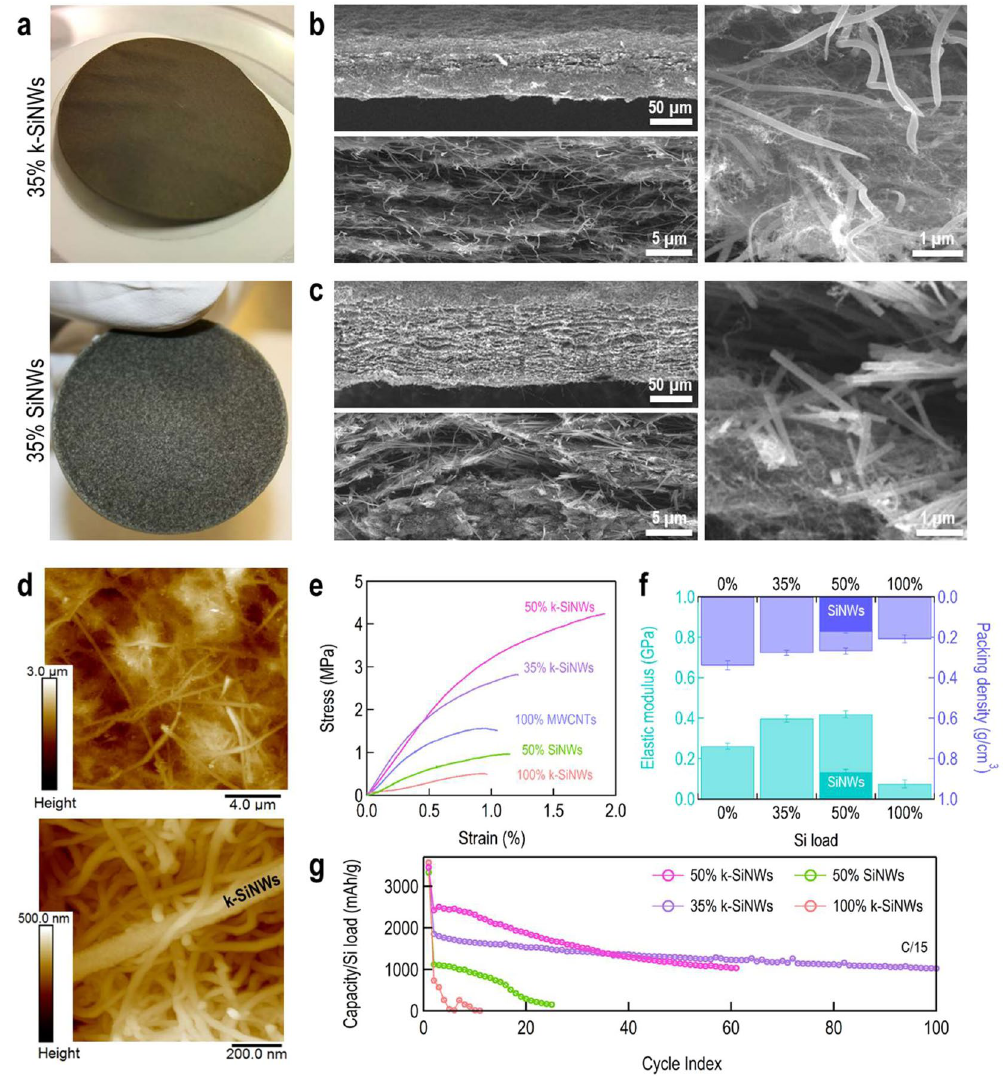
Figure 3. k-SiNWs vs. SiNWs electrode configurations. Optical images of the assemblies with a content of 35% wt. k-SiNWs and 35% wt. SiNWs ( a ). The k-SiNWs assembly presents an uniform color, indicating an homogenous distribution of elements. On the other hand, with the SiNWs-based assembly, distinct regions are identifiable, dominated by either SiNWs or MWCNTs. SEM images with details on the composition of the k-SiNWs assembly ( b ) and SiNWs assembly ( c ). Topography information as revealed by atomic force microscopy ( d ). Characteristic tensile stress-strain curves of the studied assemblies ( e ). Adjustment of elastic modulus (left axis) and packing density (right axis) to the Si load ( f ). Electrochemical performance of the Si- based assemblies evaluated at a rate of C/15 (1 C corresponds to 3600 mA/g) ( g